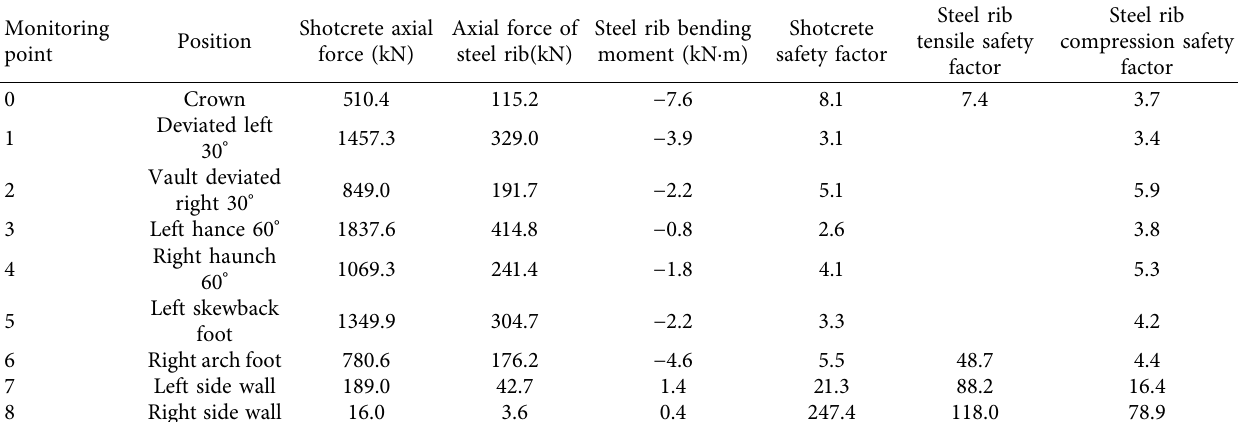
Table 9: Internal force and safety factor of primary support under parameter